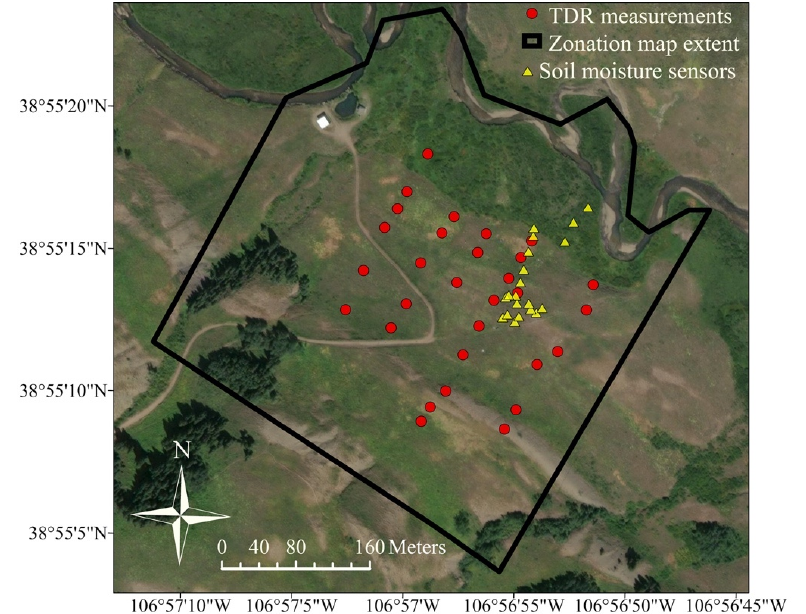
Figure 4. Locations of 20 soil moisture sensors logging hourly volumetric water content